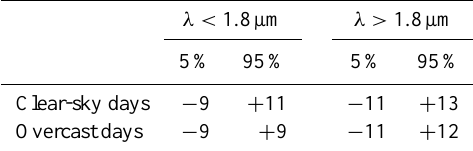
Table 4. Total 5 and 95% errors of α (in percentages) calculated according to Eqs. (A1) and (A2) in Appendix A, averaged over the examined clear and overcast